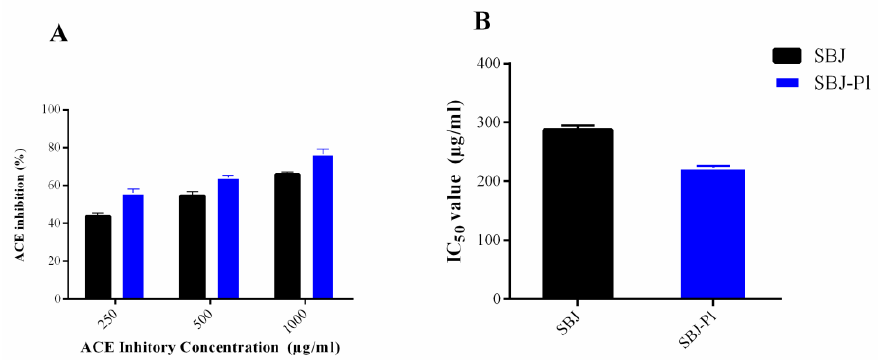
Figure 5. ACE inhibitory activity of sea buckthorn juice extracts. ( A ) ACE inhibitory activity of sea